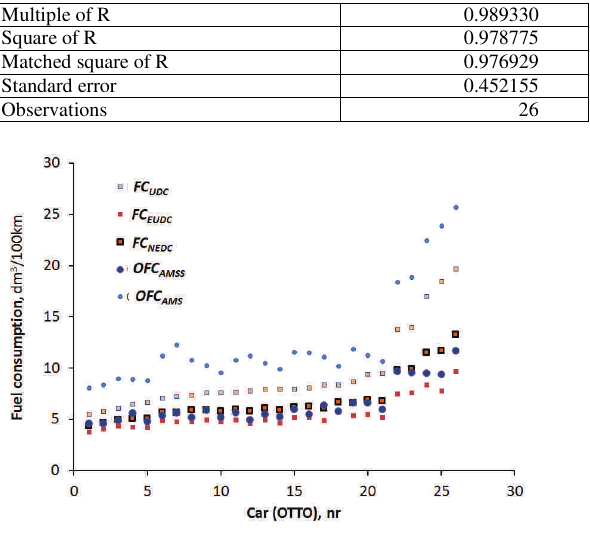
Fig. 4. The research results of fuel consumption in bench tests (FC NEDC , FC EUDC and FC UDC ) and in controlled operating tests (OFC AMS , OFC AMSS ) of vehicles with spark ignition engines You can see large variances in the results of the tests and those listed in the pilot operation.